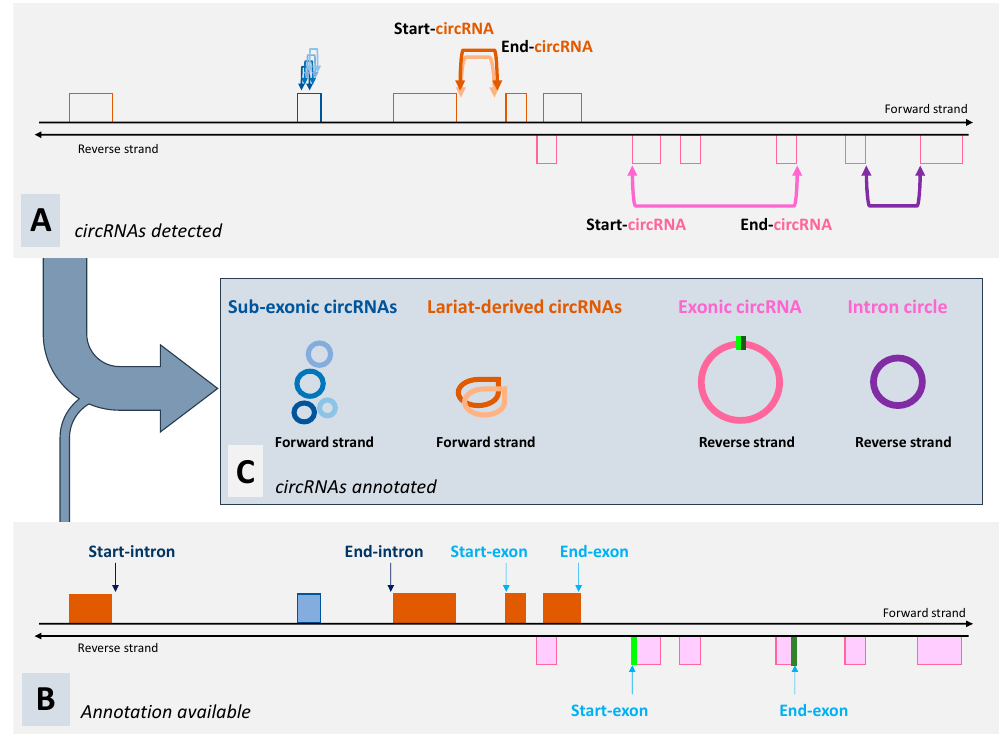
Figure 2. Detection and annotation of circRNAs. ( A ) In this region, several circRNAs (4× blue, 2× brown, 1× pink, and 1× purple) are detected. ( B ) Three genes are described in this region: two on the forward strand (brown gene and blue gene) and one on the reverse strand (pink gene). ( C ) Annotation of circRNAs. The circRNA indicated in pink can be annotated as exonic circRNA (canonical circRNA). In the circular junction sequenced, an exonic downstream donor 3 ′ splice site (indicated in green in ( B )) is covalently joined to an exonic upstream 5 ′ splice site (indicated in dark-green in ( B )). The parent gene of this exonic circRNA is the pink gene. For the two circRNAs indicated in brown, they are mapped on the forward strand inside intronic sequences of the brown gene located on the same strand. As the position ‘Start-circRNA’ (see ( A )) is identical to the position ‘Start-intron’ (see ( B )) and the distance between the position ‘End-circRNA’(see ( A )) and the position ‘End-intron’ (see ( B )) is less than 60 nt, we can annotate these two circRNAs as lariat-derived circRNAs from the brown gene. The circRNA indicated in purple is mapped on the reverse strand inside an intron of the pink gene located on the same strand. We can note identical genomic coordinates for ‘Start-circRNA’ and ‘Start-intron’ and for ‘End-circRNA’ and ‘End-intron’. Thus, we can annotate this circRNA as an intron circle produced by the pink gene. When we examine the characteristics of the four circRNAs indicated in blue, we observe that they are compatible with a set of sub-exonic circRNAs produced by the blue gene, which is a non-coding gene. Indeed, their genomic coordinates are located inside the single exon of this gene and the transcription strand is identical.